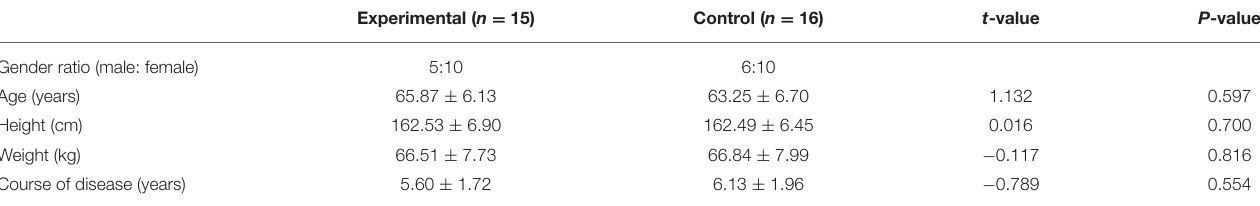
TABLE 1 | Participant demographics and anthropometrics.